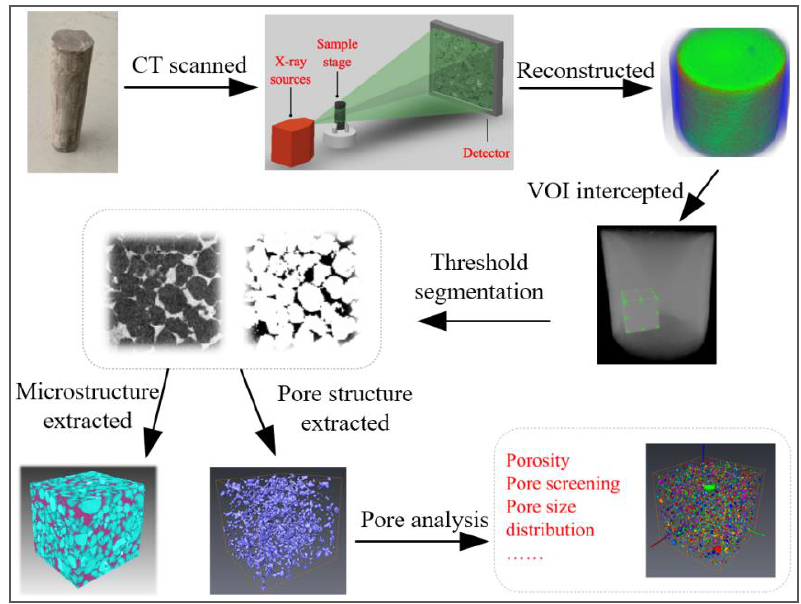
Figure 5. The flowchart of pore structure test and analysis using micro-CT.